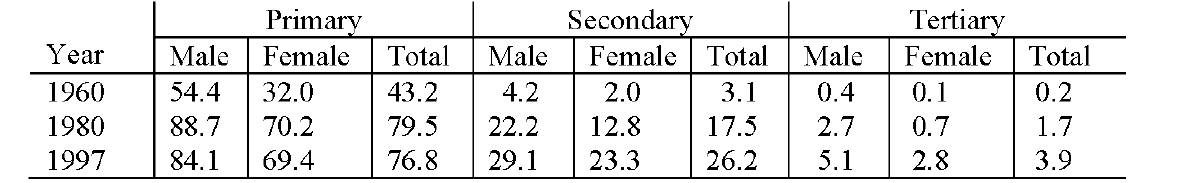
Table 1. Education: Gross enrolhnent rates in Sub-Saharan Africa, 1960-1997 (percent) Primarv Secondar Tertiarv Year Male Female Total Male Female Total